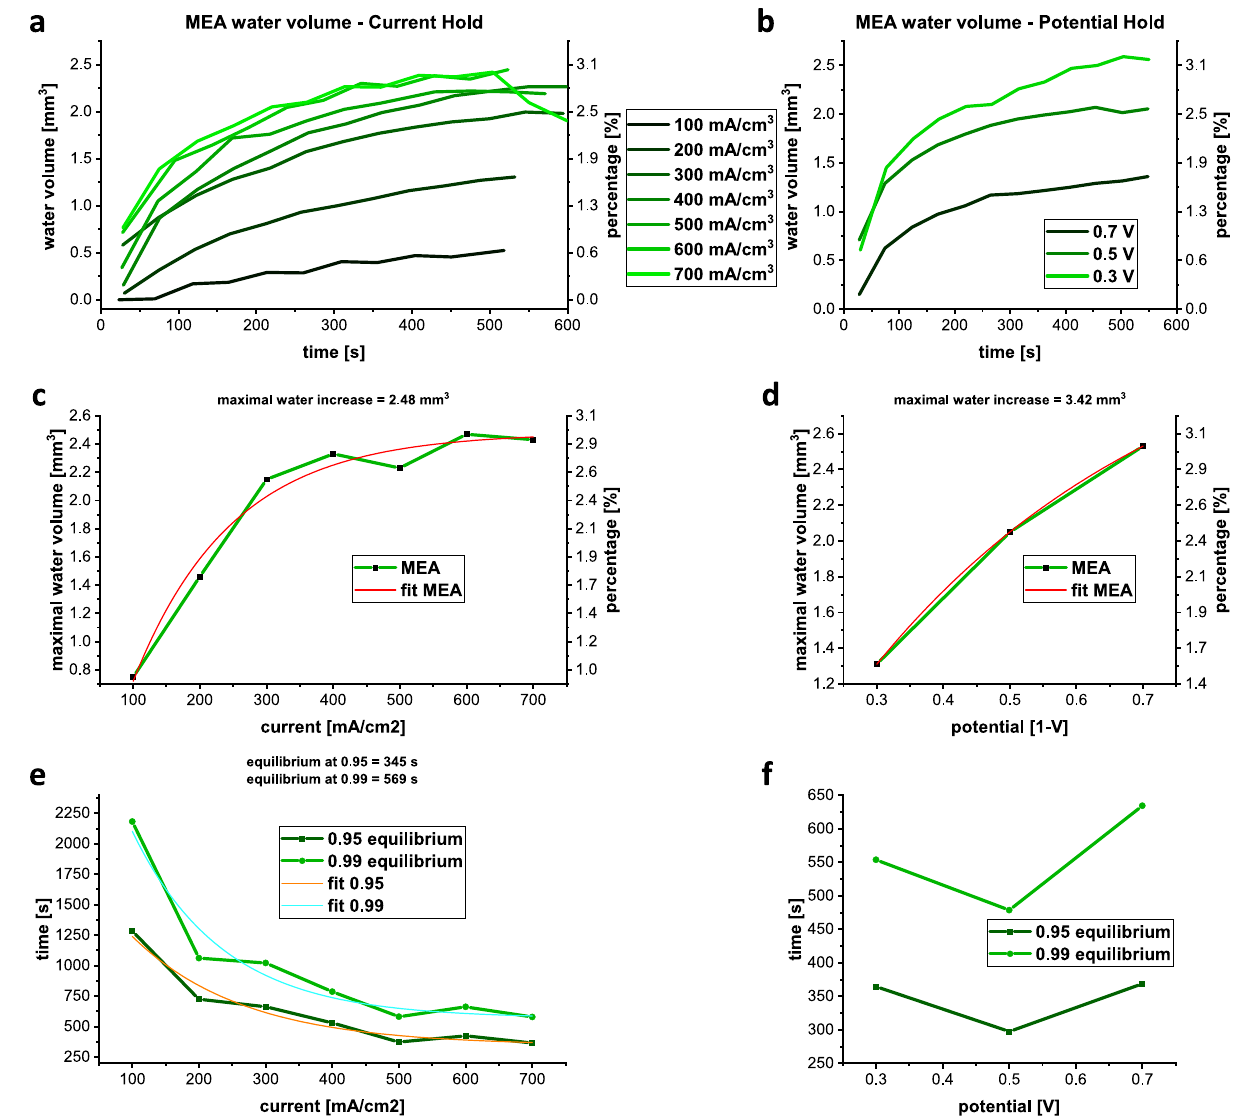
Fig. 4 MEA water evolution, calculation of the current and potential-dependent water formation and time to reach the water volume equilibrium. a and b The volume increase of the water generated inside the MEA for constant current density and potential, respectively. Higher currents/ lower potentials cause a faster water uptake, which saturates for higher operational cell power. c and d Determine the maximal water volumes in the MEA. To use the same saturation function the potential values in d are reversed with a maximal open circuit potential of 1.0 V. e and f Evaluates the time needed to reach the water equilibrium for given current and potential densities of 95 % and 99 % of equilibrium, with corresponding fi t functions for e . A fi t for f is not possible due to the large uncertainties and small number of